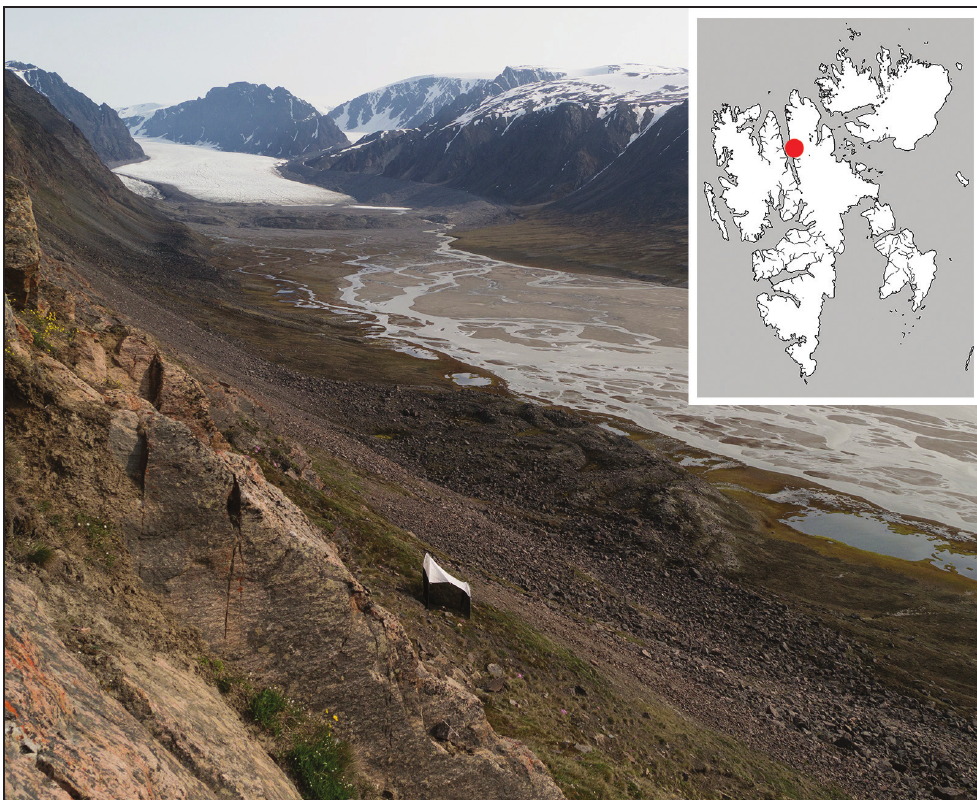
Figure 2. Ringhorndalen in Indre Wijdefjorden National Park where Plutella polaris was rediscovered in 2015. The inserted map shows Svalbard with the exact position of the locality (red circle). (Photo: G.